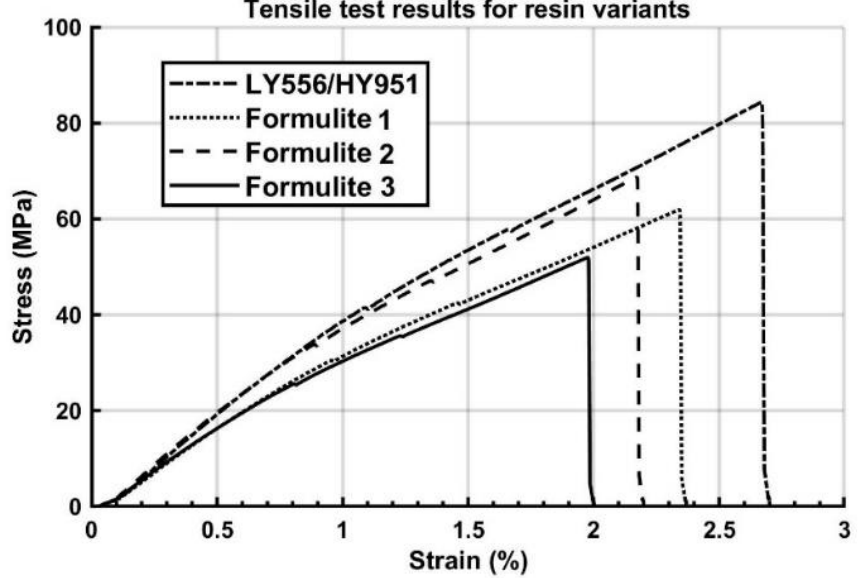
Figure 8. Stress–strain graph for samples tested for tensile properties. Figure 8. Stress – strain graph for samples tested for tensile properties.